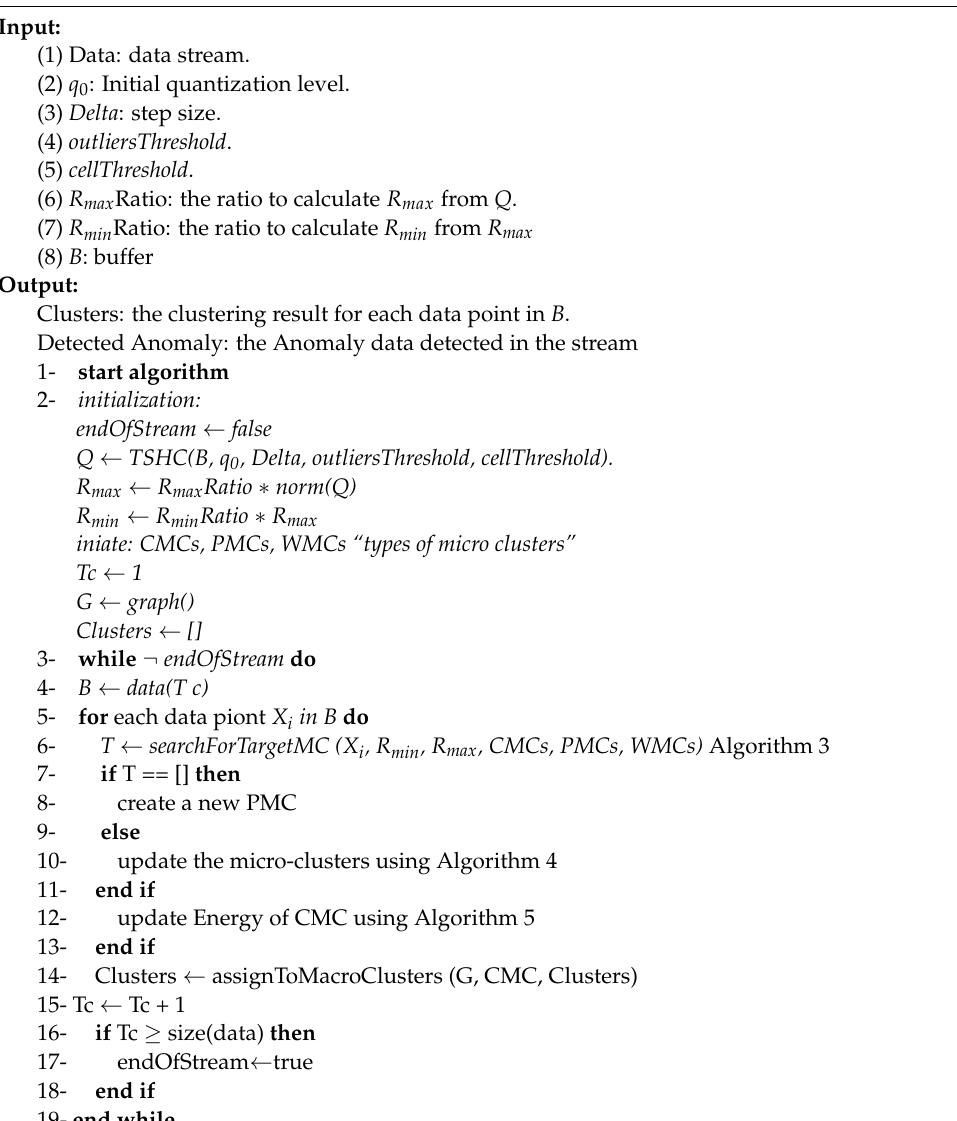
Algorithm 2: TSHC